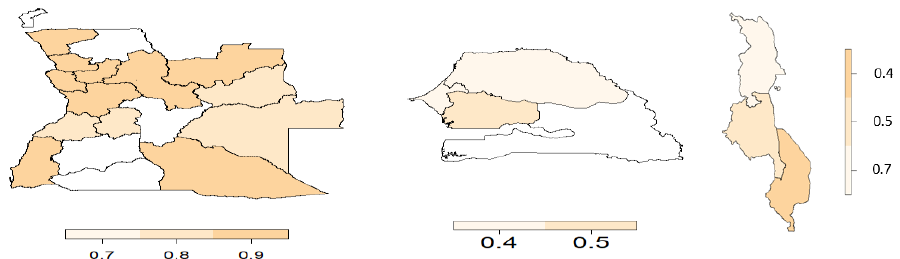
Figure 6. Joint probability of a child being malnourished and anaemic. ( Left ) Angola, ( middle ) Sen- egal, and ( right ) Malawi.